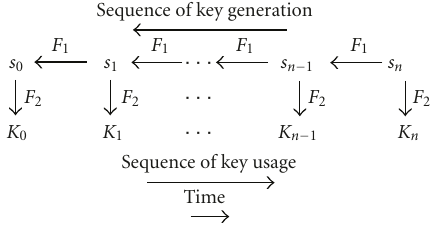
Figure 1: TESLA key